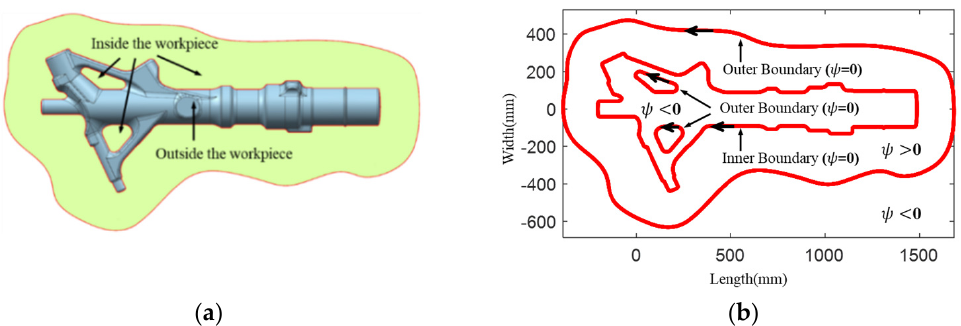
Figure 2. Cross section and boundary of a landing gear die: ( a ) Cross section; ( b ) Boundary.